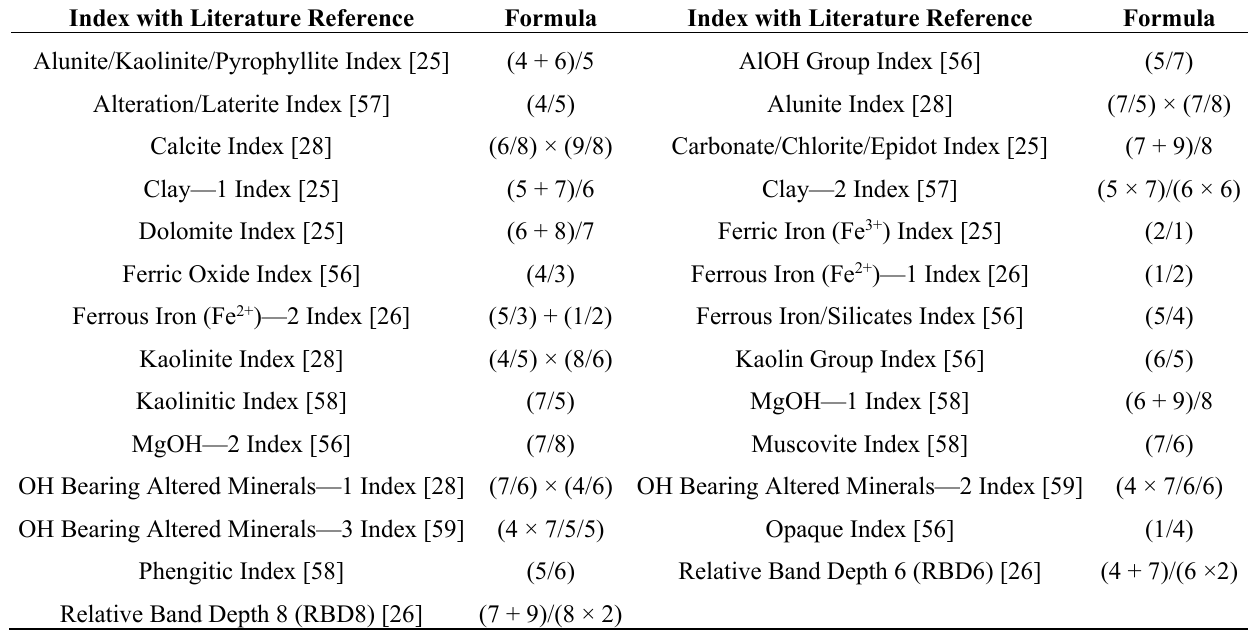
Table 2. Spectral indices of ASTER VNIR and SWIR